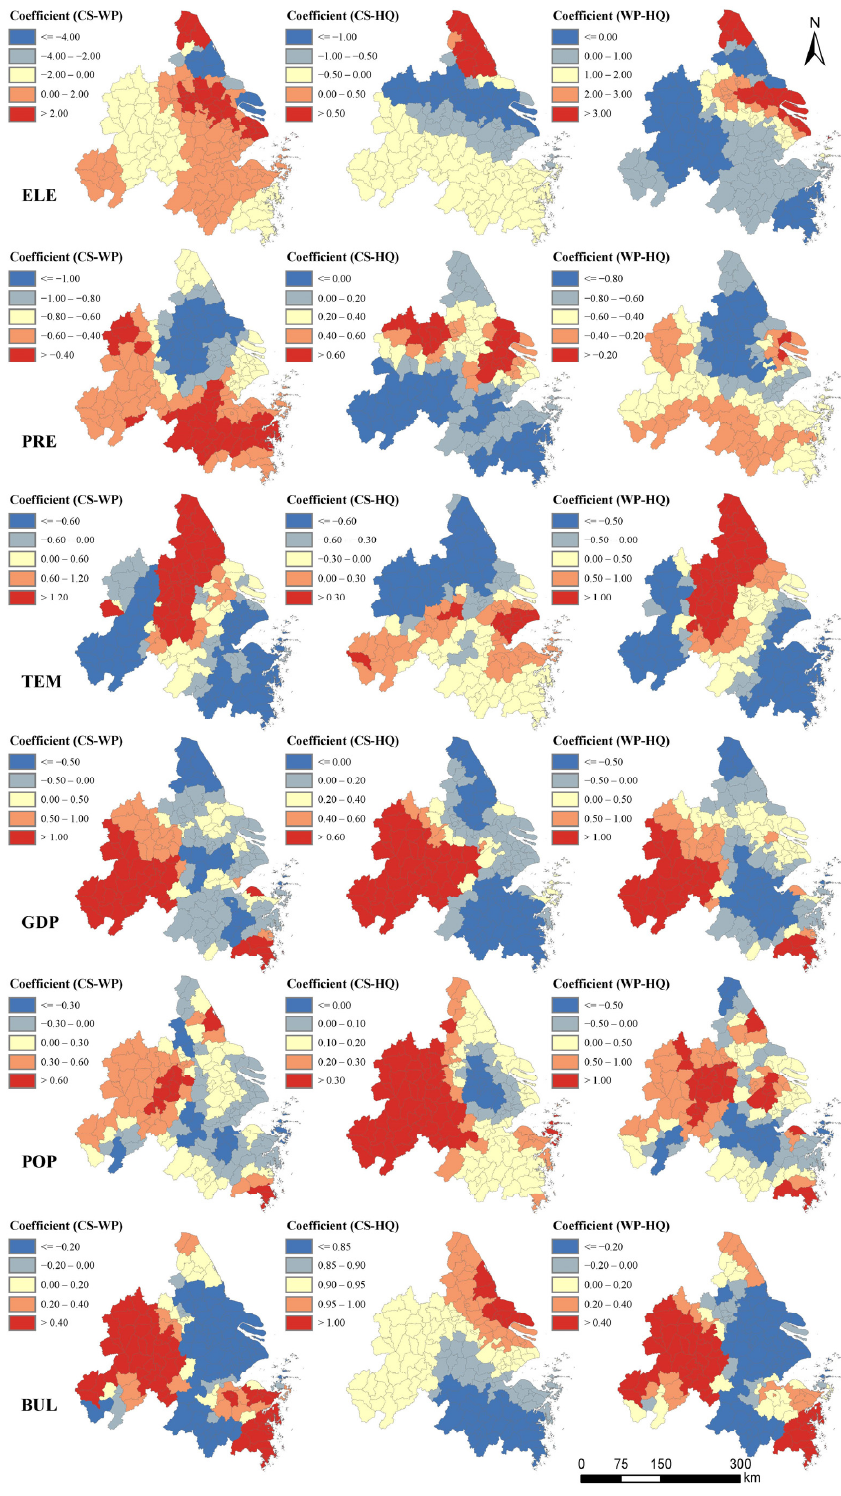
Figure 8. Coefficients of the relationship between the TSD of paired ESs and six variables using the GWR model.